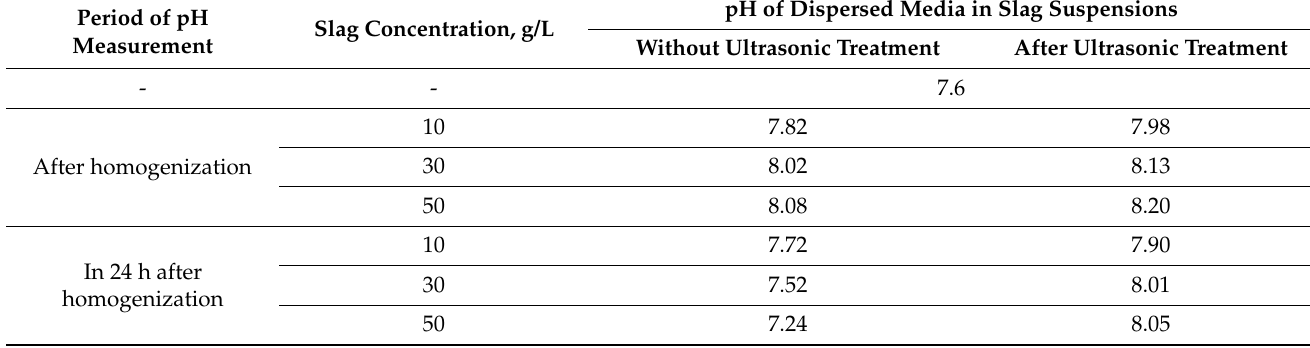
Figure 8. The mechanism of interaction of slag particle (Ca 2 SiO 4 ) with water. Table 7. pH of the dispersed medium in the “slag-water” system. Table 7. pH of the dispersed medium in the “slag-water”